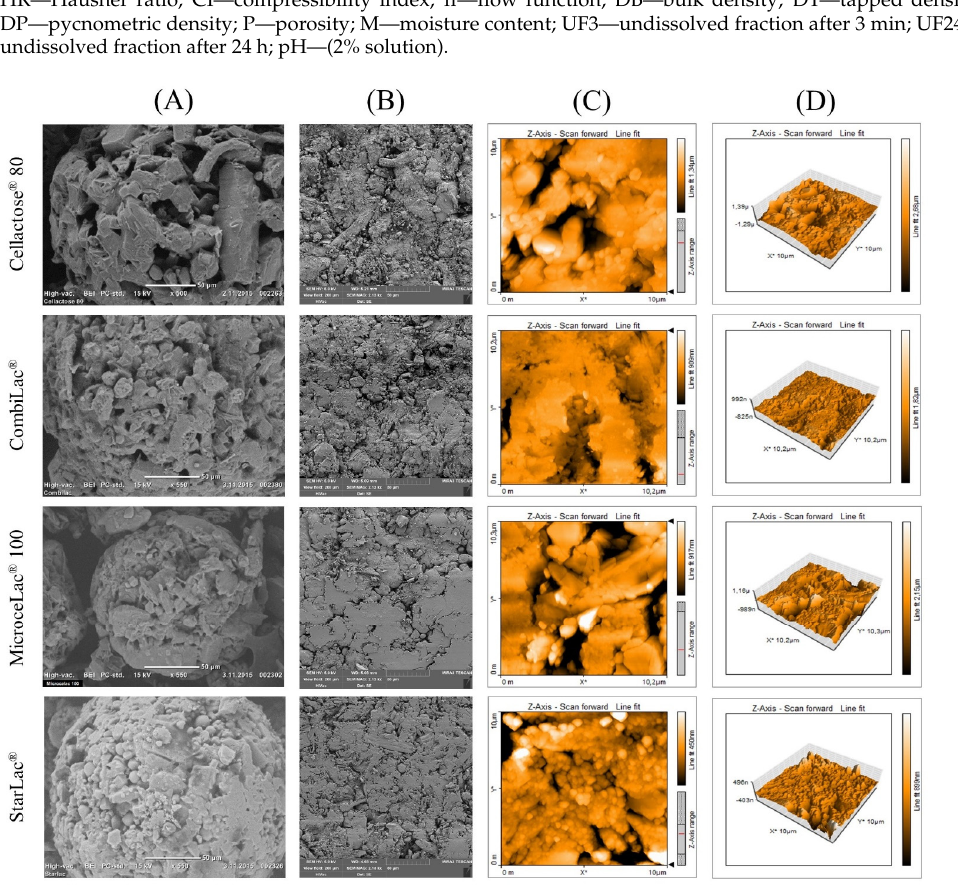
Figure 2. SEM pictures of ( A ) CPE particles (500×, 550×) and ( B ) compacts compressed at 182 MPa. ( C , D ) AFM scans of compacts compressed at 182 MPa. ( C , D ) AFM scans of compacts compressed at 182